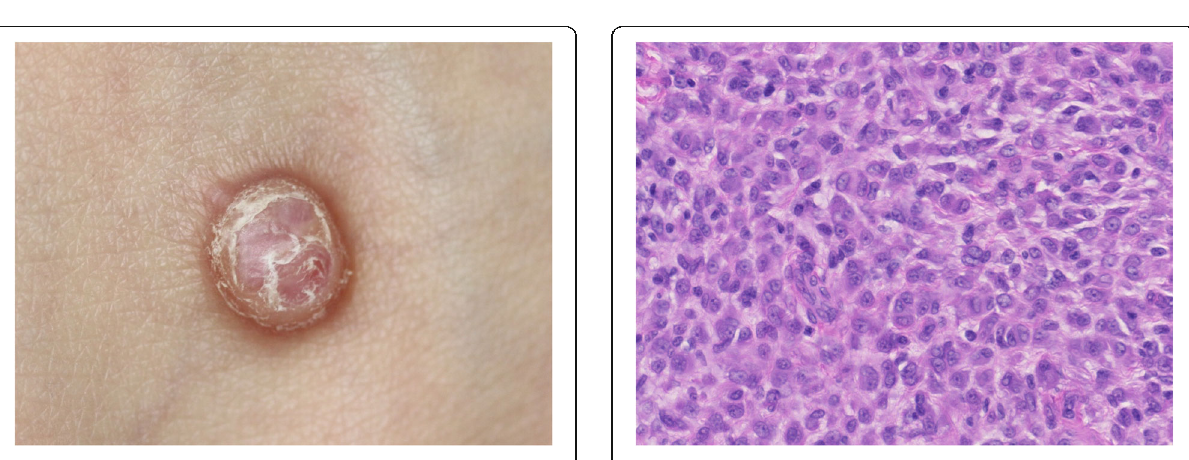
Fig. 3 Histological findings. The tumor was composed of sheets of epithelioid cells with eosinophilic